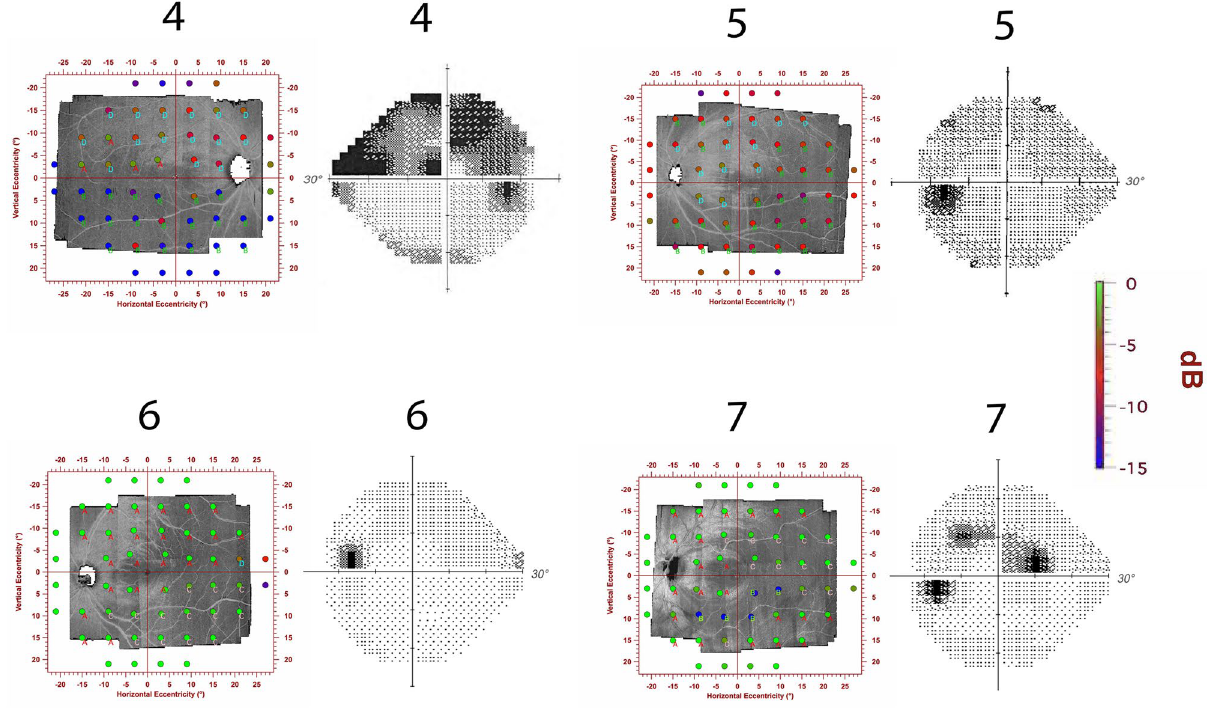
Figure 5. Perimetric locations superimposed on en face images of the RNFL bundles for 4 participants. These 4 participants are extreme cases of structure–function discordance as in Fig. 3. Categories A, B, C and D